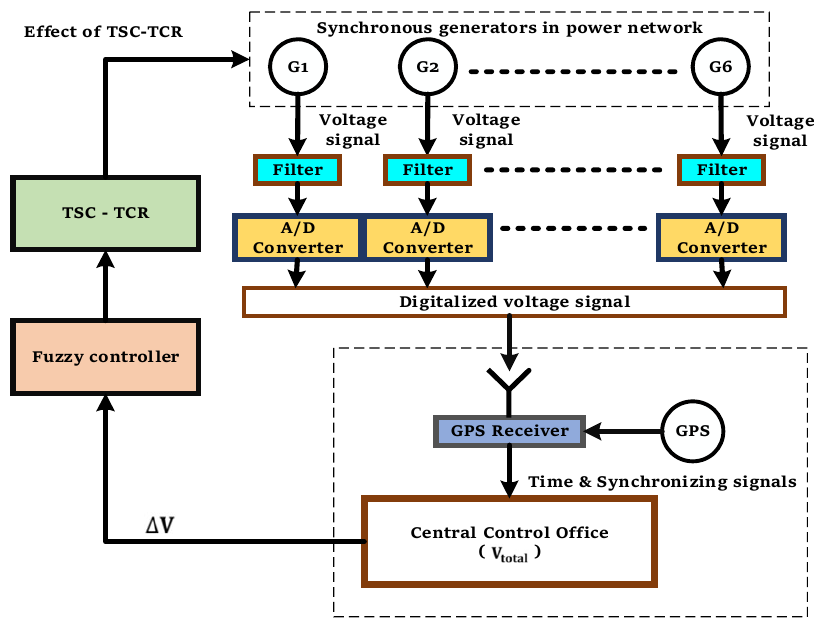
Figure 5. GPS-enabled shuttered monitoring